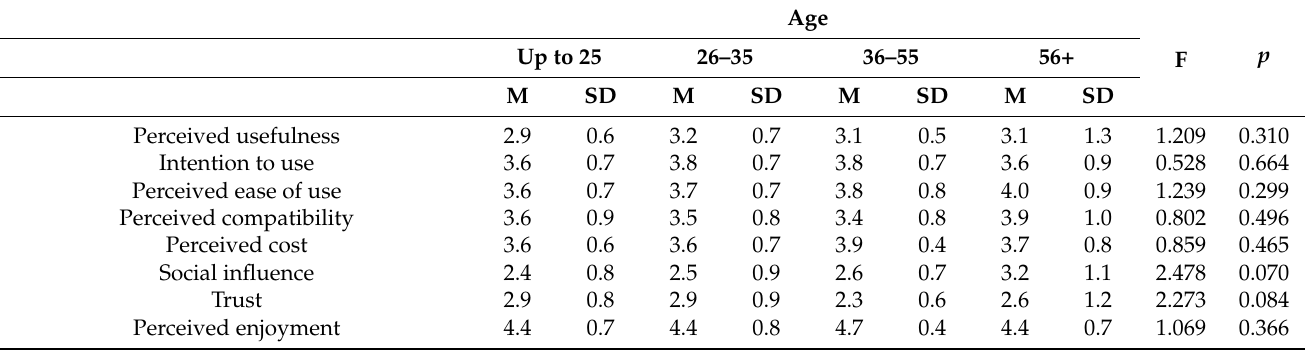
Table A14. t -test results for the differentiation of factors and intention to use services according to the age